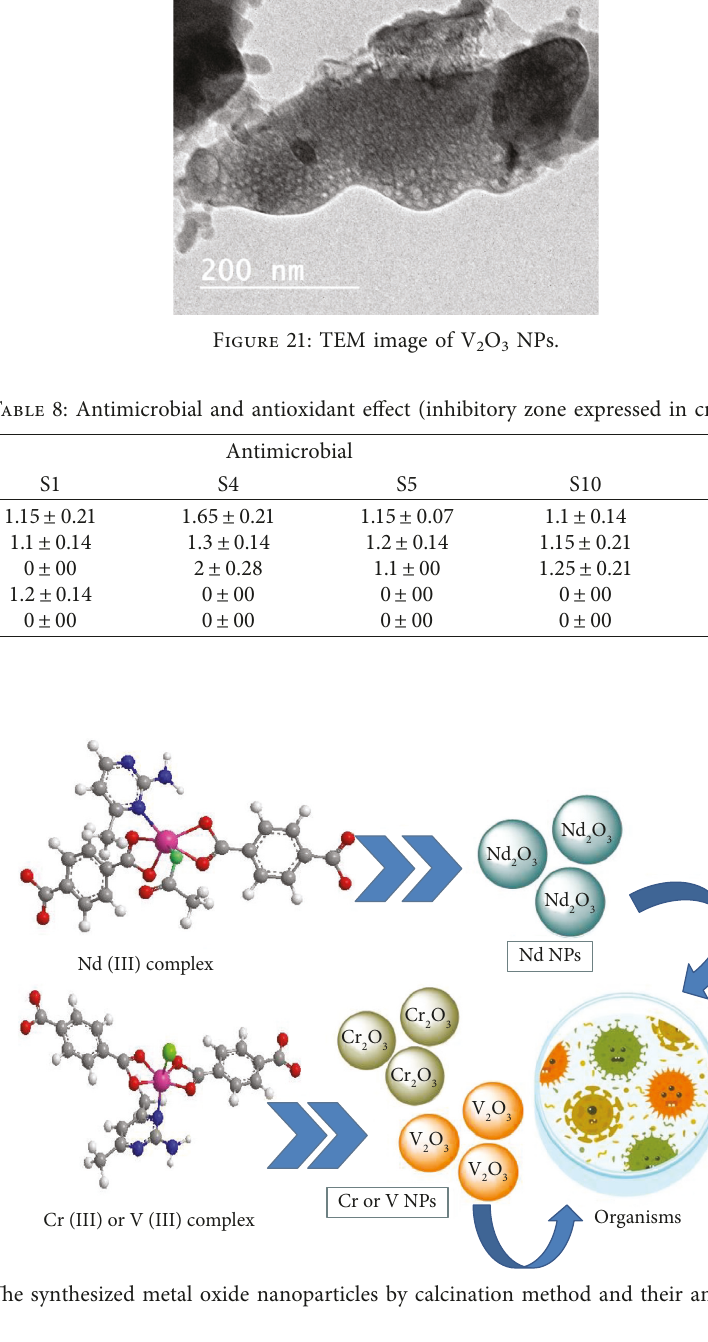
Figure 22: The synthesized metal oxide nanoparticles by calcination method and their antimicrobial activity.